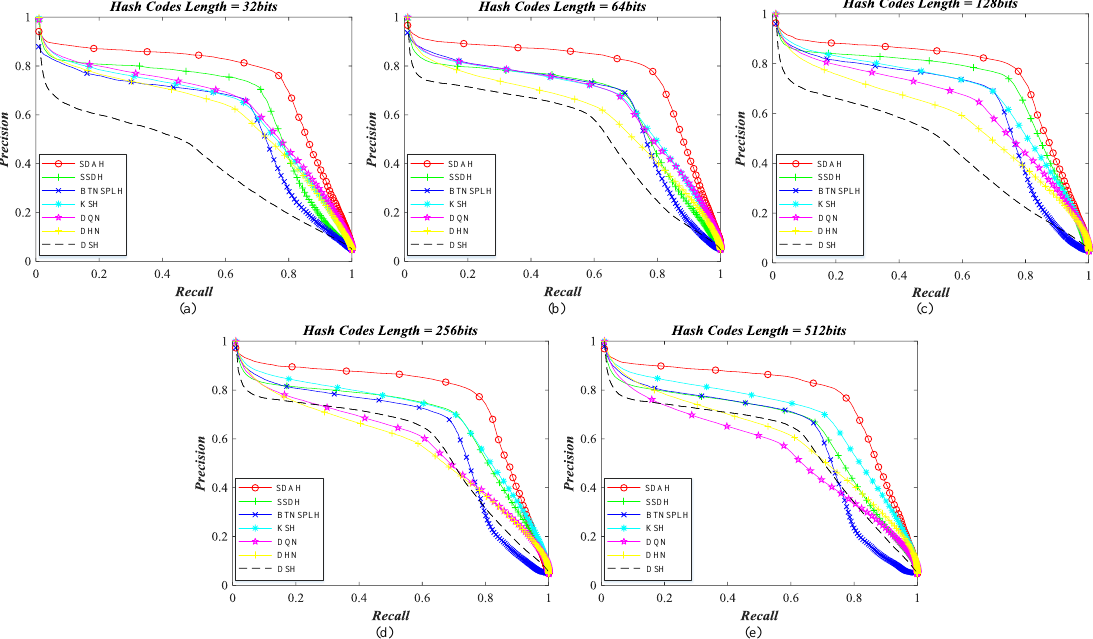
Figure 8. Retrieval precision–recall curve of different hashing methods counted on UCM archive: ( a ) the length of hash codes is 32 bits; ( b ) the length of hash codes is 64 bits; ( c ) the length of hash codes is 128 bits; ( d ) the length of hash codes is 256 bits; and ( e ) the length of hash codes is 512